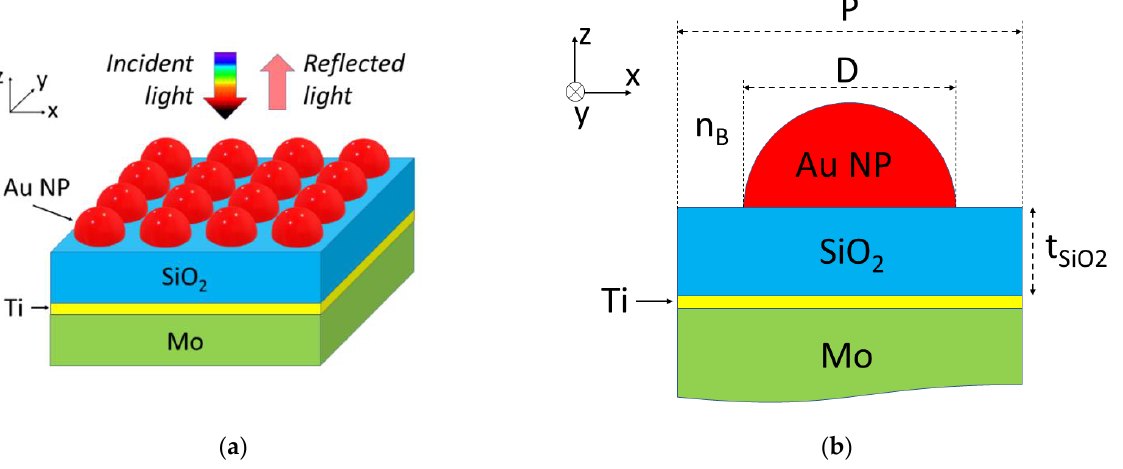
Figure 2. ( a ) Schematics of the modeled self-referenced plasmonic sensor based on Au nanoislands. The sensor is interrogated in reflection mode; ( b ) schematic cross-sectional view of the simulated device. The thickness of the SiO 2 layer, t SiO2 , equals 100